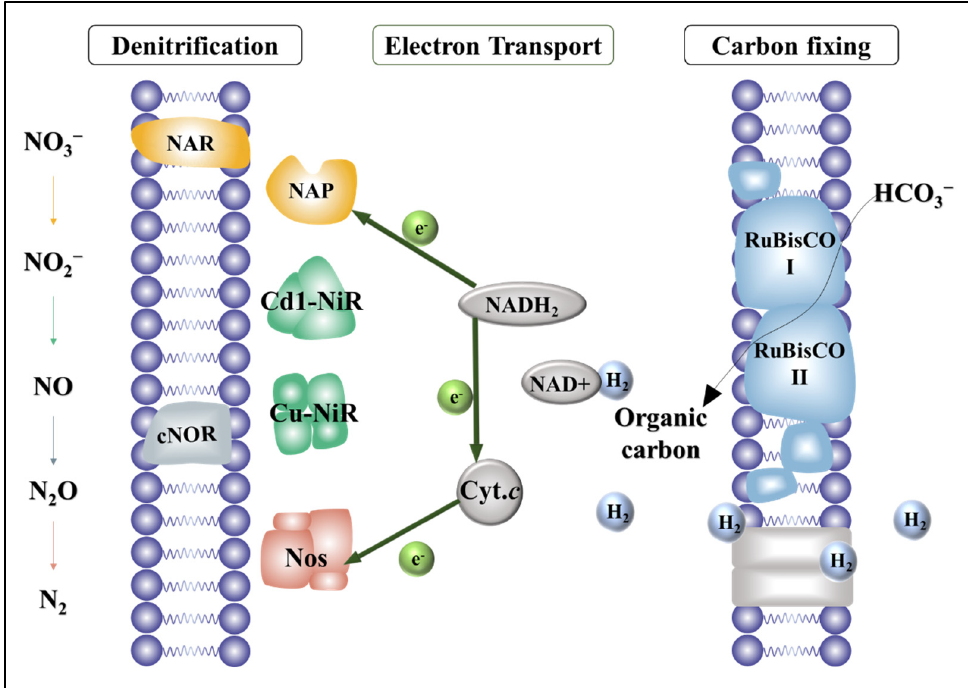
Figure 1. Schematic of the respiratory chain of denitrification. Electrons are transferred from NADH 2 to NO x reductases (i.e., nitrate, nitrite, nitric oxide and nitrous oxide reductases).